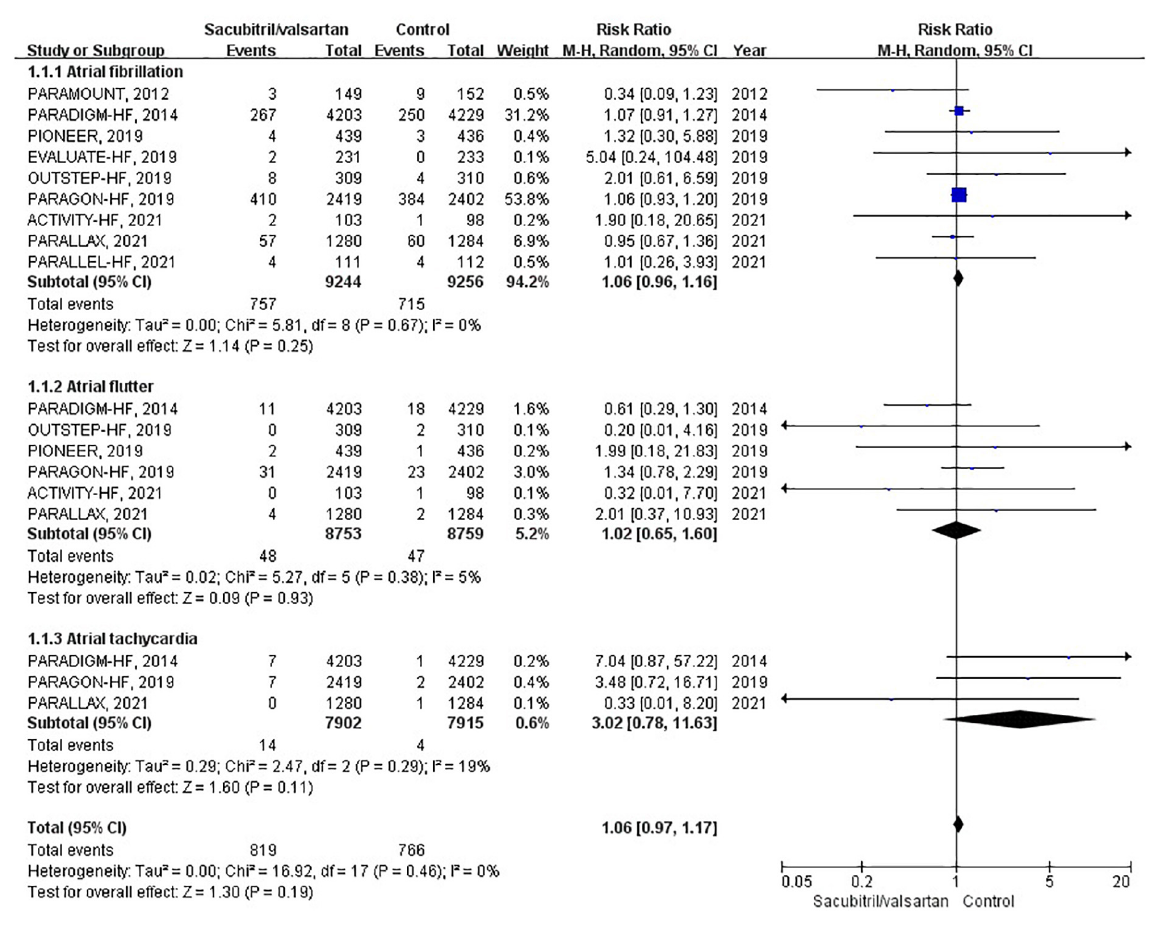
FIGURE3 Forest plot comparing the occurrence of atrial arrhythmias between sacubitril/valsartan and